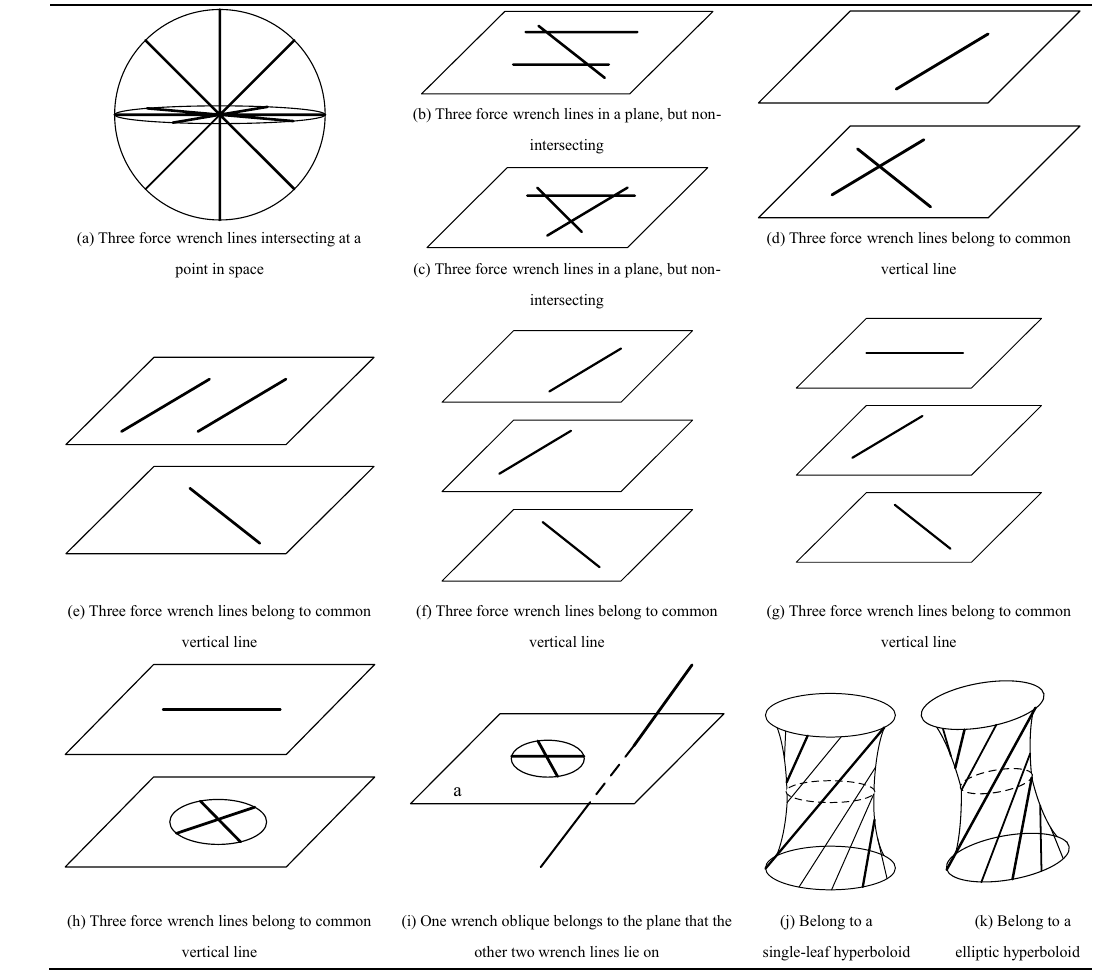
Table 3 Actuation space line